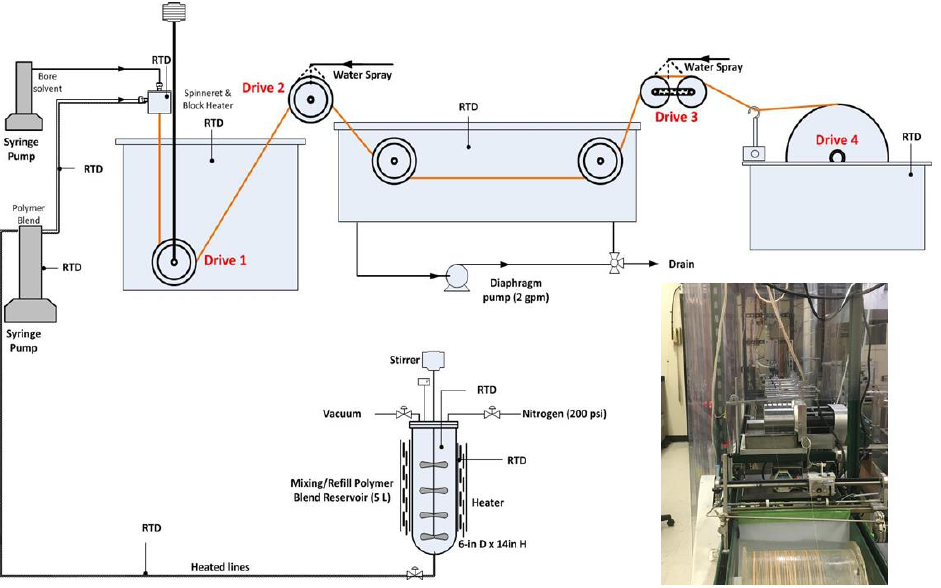
Figure 2 . Schematic and photo image of spinning line . RTD is resistance thermometer. Figure 2. Schematic and photo image of spinning line. RTD is resistance